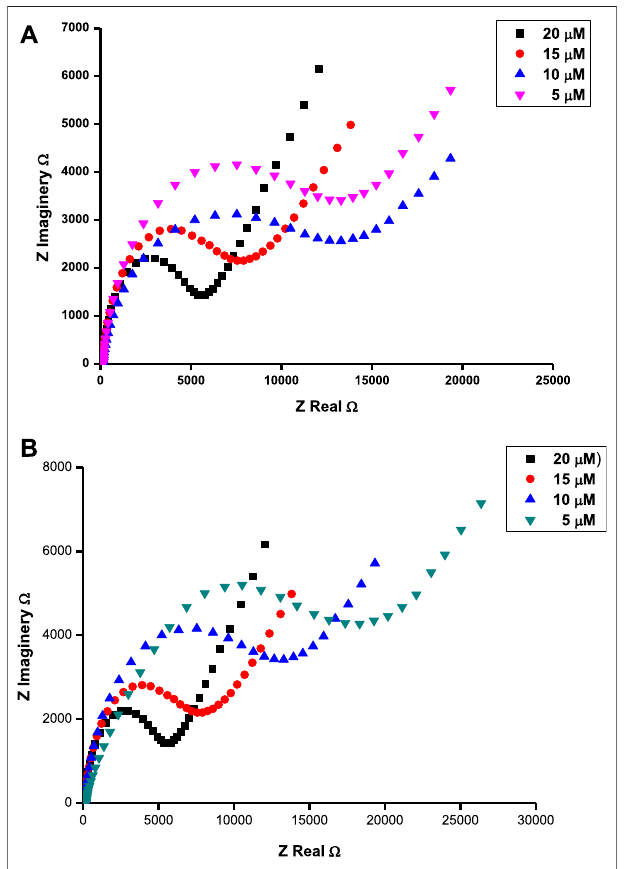
FIGURE 6 | Nyquist plots for ascorbic acid at 0.37 V (A) and tryptophan at 0.72 V (B) in different concentrations of respective analytes on the surface of poly-CoTCPc-CoTAPc-GONS/GCE at pH